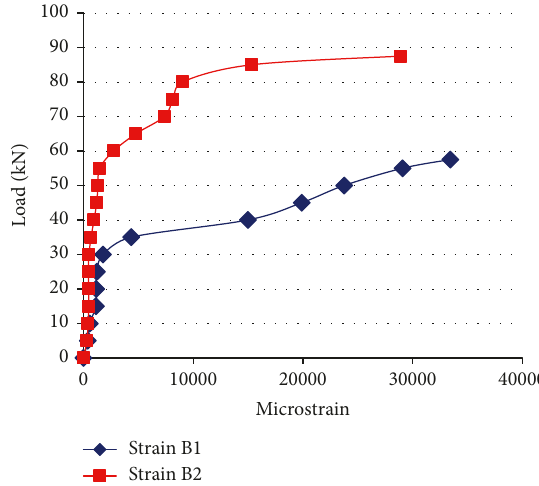
Figure 7: Effect of carbon fiber on load-strain response for beams having clear span � 1400mm.